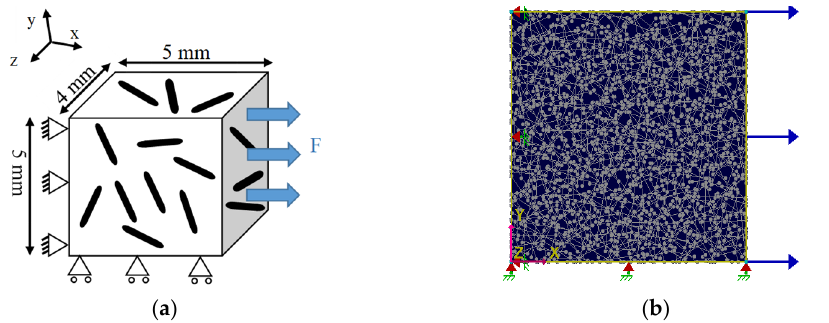
Figure 4. Representative volume element (RVE) in the PF approach: ( a ) explanatory diagram; ( b ) RVE generated using KSP software.